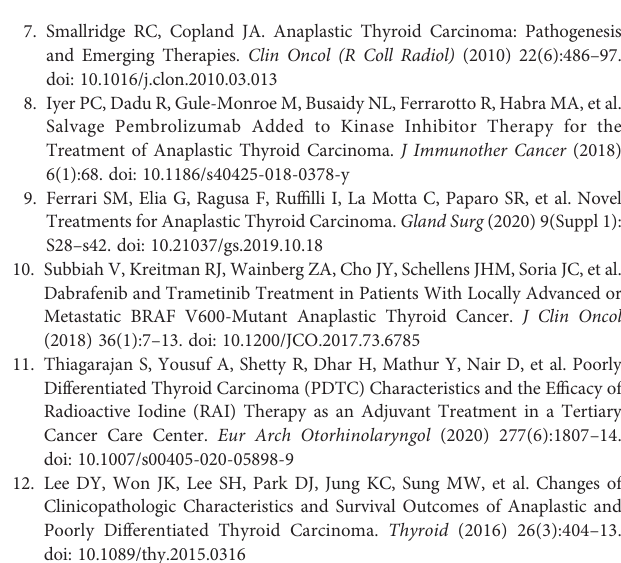
Supplementary Figure 1 | Kaplan-Meier plots of DSS in patients according to PD-L1 expression. Disease speci fi c survival of ATC (A) and PDTC (B) patients with TPS categories <50% and ≥ 50%). Supplementary Figure 2 | Kaplan-Meier plots of DSS in patients according to panFGFR expression. Disease speci fi c survival of ATC (A) and PDTC (B) patients with mean panFGFR expression (2 mRNA/cell [ATC], 3 mRNA/cell